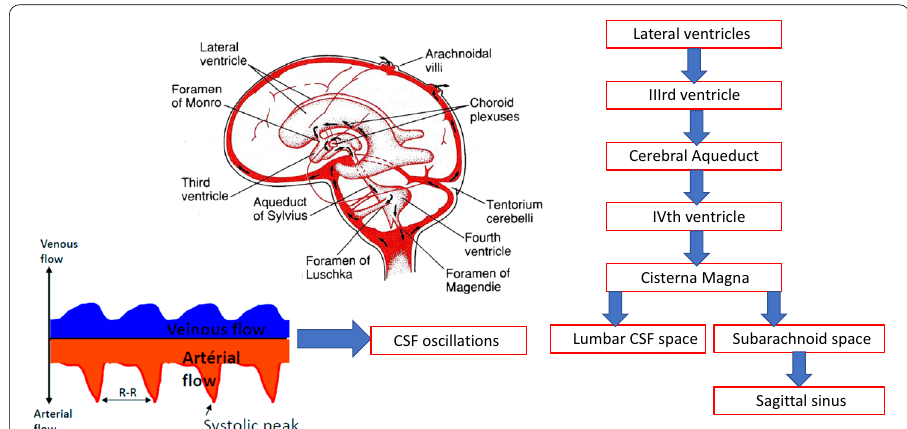
Fig. 1 CSF circulation. Overview of the ventricular system. CSF is produced and flows from the choroid plexuses in the lateral ventricles into the third and then fourth ventricle via the foramina of Monro and the cerebral aqueduct, respectively. From the IVth ventricle, CSF empties into the cisterns of the skull base through the foramen of Magendie and foramina of Luschka and subsequently into the lumbar CSF space and the subarachnoid space at the sagittal sinus. Cardiac contraction induces an arterial distension during systole and a subsequent recoiling during diastole. A portion of this energy is transferred to the brain in the form of brain pulsation and to the CSF in the form of CSF pulsation. This dissipation of arterial blood flow energy by the CSF pulsation energy provides for the maintenance of low intracranial pressure (ICP) according to